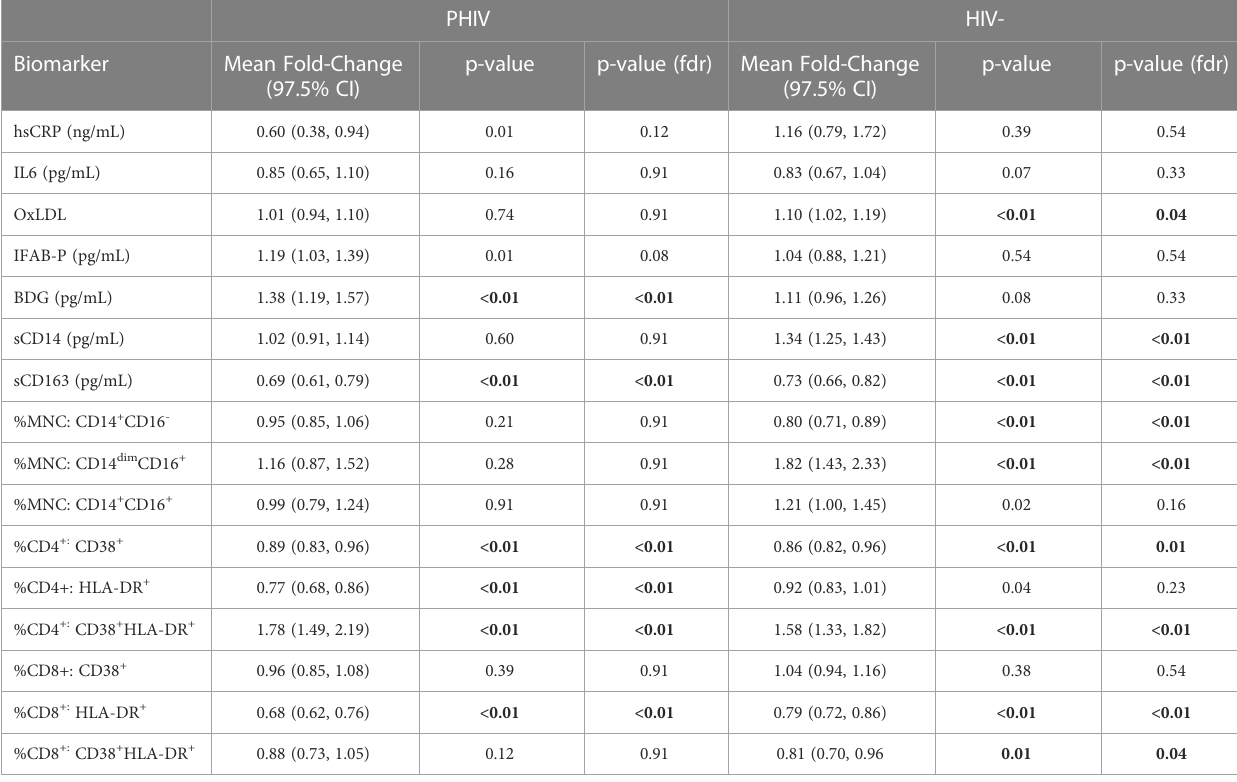
TABLE 2 Mean Fold change (97.5% Con fi dence Interval) from Baseline over 96 weeks by